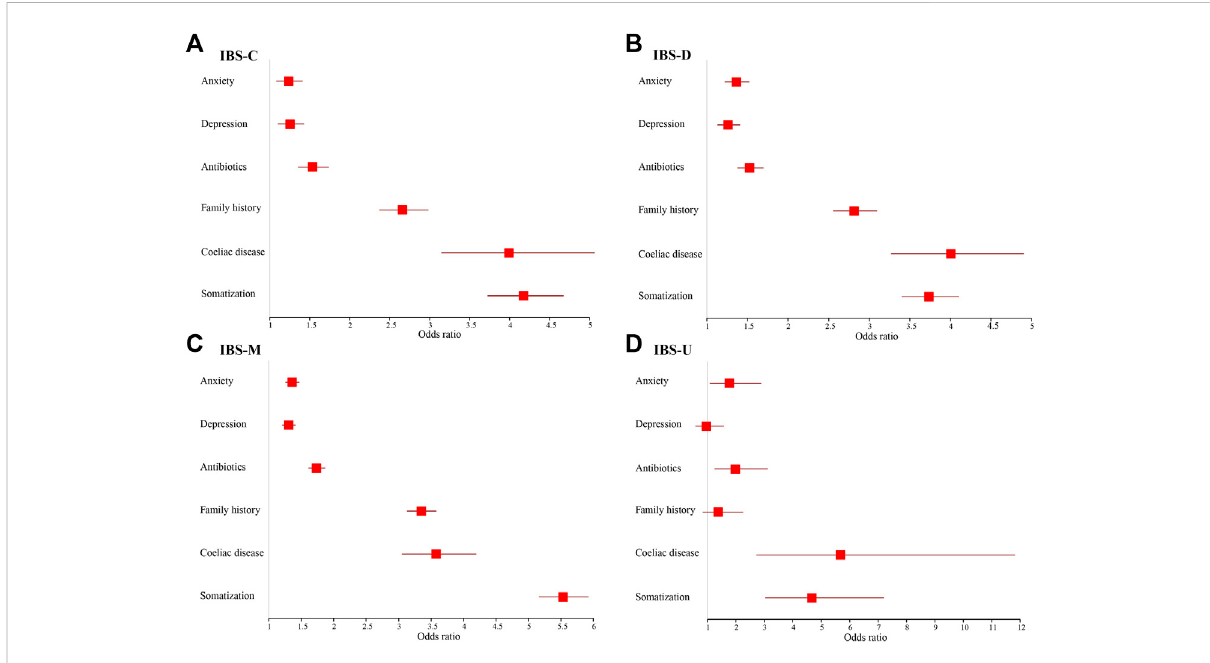
FIGURE 6 Models of factors associated with IBS subtypes for females and adjusted for age and socioeconomic status. (A) IBS-C. (B) IBS-D. (C) IBS-M. (D) IBS-U.